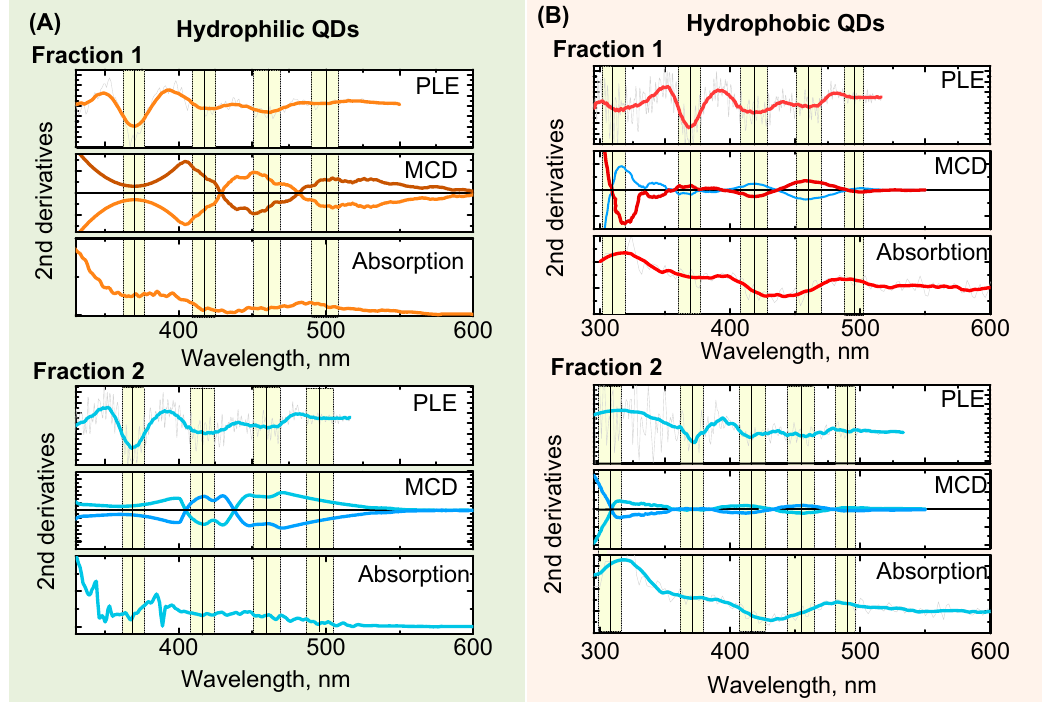
Figure 5. The second derivatives of PLE (top), magnetic circular dichroism (middle), and absorption (bottom) spectra for each fraction of hydrophilic ( A ) and hydrophobic ( B ) AgInS 2 /ZnS QDs. The position of electronic transitions is determined as positions of second derivatives minimums, marked by vertical lines with error within yellow bars. Table 1. Transition positions in nm (eV), type of magnetic circular dichroism term.